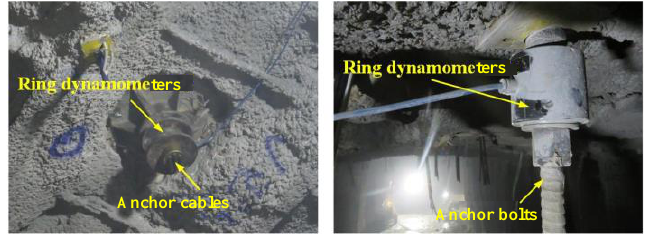
Figure 9. Layout of the steel strain gauges. Figure 8. Layout of the ring dynamometers. Figure 8. Layout of the ring dynamometers.